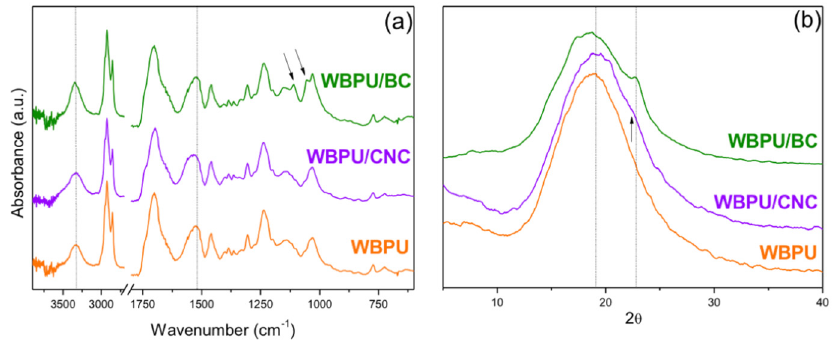
Figure 6. ( a ) FTIR spectra; ( b ) X-ray diffraction spectra of the neat WBPU and the nanocomposites.